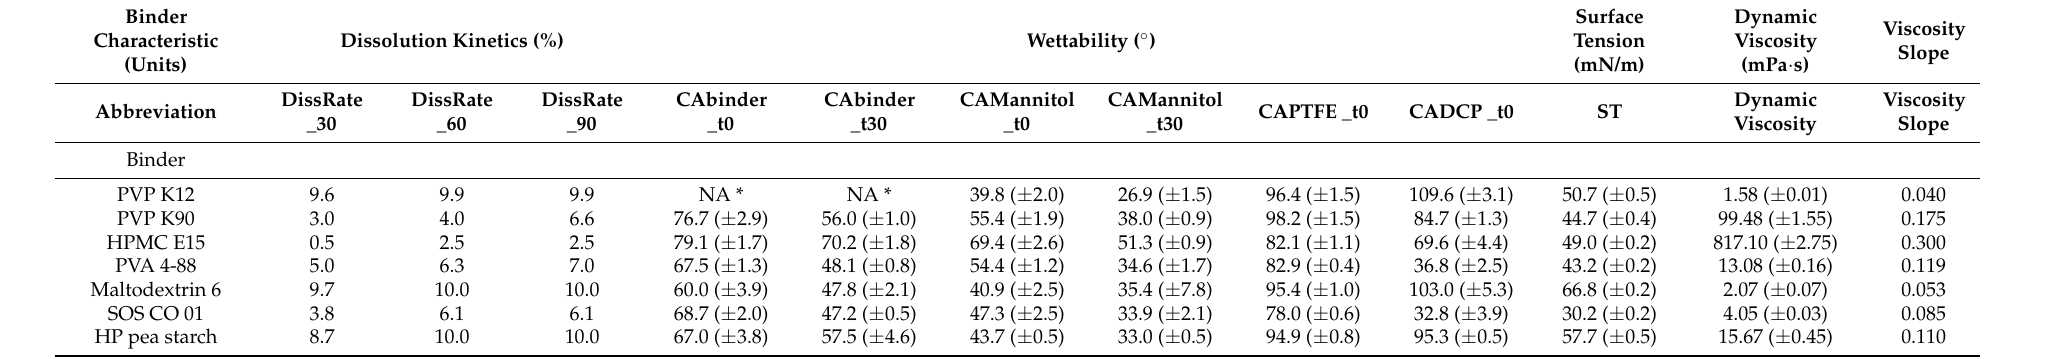
Table 4. Numerical values of binder attributes used for PCA_2 and for the PLS model. CAPTFE_t0 and CADCP_t0 were only included in the PLS model [16]. (* Values could not be presented, as tablets of PVP K12 could not be prepared due to too high ejection forces.). Binder